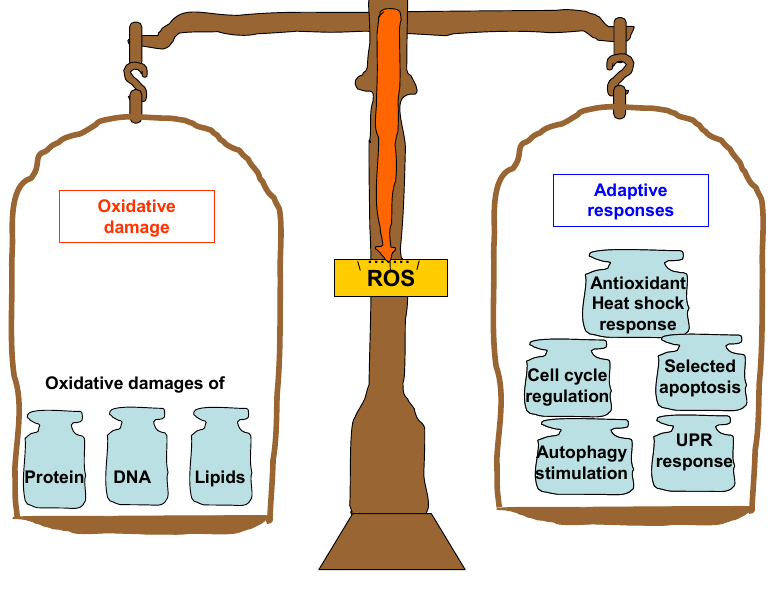
Figure 2. Summary of the bifurcated effects that can be induced by ROS. On the one hand, ROS induces the oxidative damage to proteins, DNA and lipids. On the other hand, they also trigger the organism’s adaptive responses including antioxidant and heat shock responses, fatty acid deacylation-reacylation, cell cycle regulation, DNA repair and apoptosis, unfolded protein responses, and autophagy stimulation.